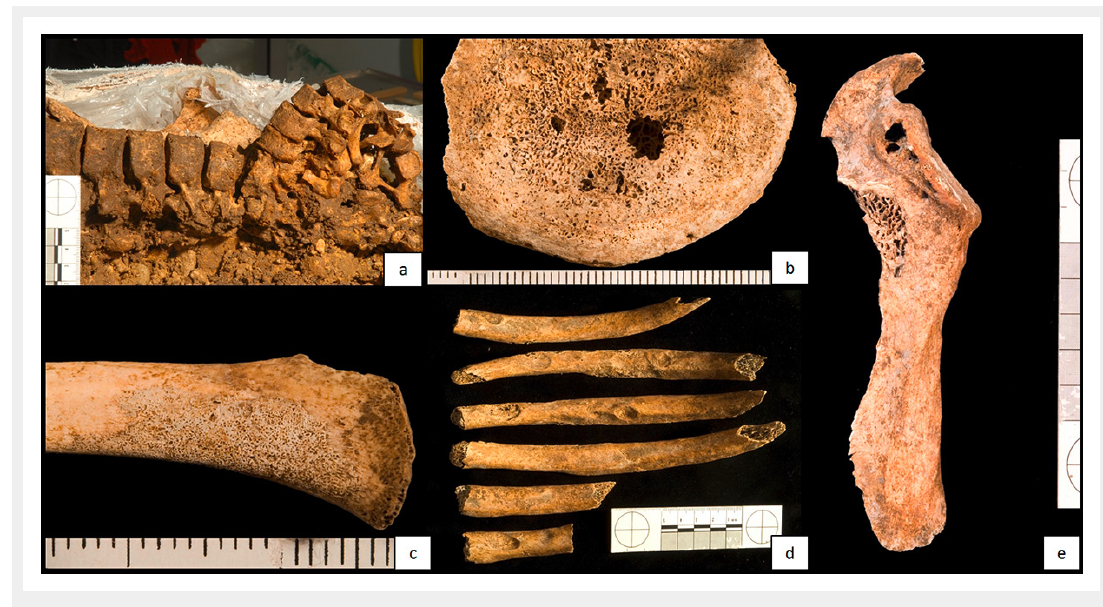
Figure 3 a: Angular kyphosis of the spine due to destruction of the vertebral bodies of the fourth to eighth thoracic vertebrae as found in situ (grave 94), the thoracic region of this skeleton was recovered in a cast due to the pathological alterations; b: lytic lesions in the endplate of a lumbar vertebra (grave 116); c: new bone formation on the vertebral end of a rib (grave 82); d: lytic lesions and new bone formation on the visceral rib surfaces (grave 127), e: lytic lesions in the scapula (grave